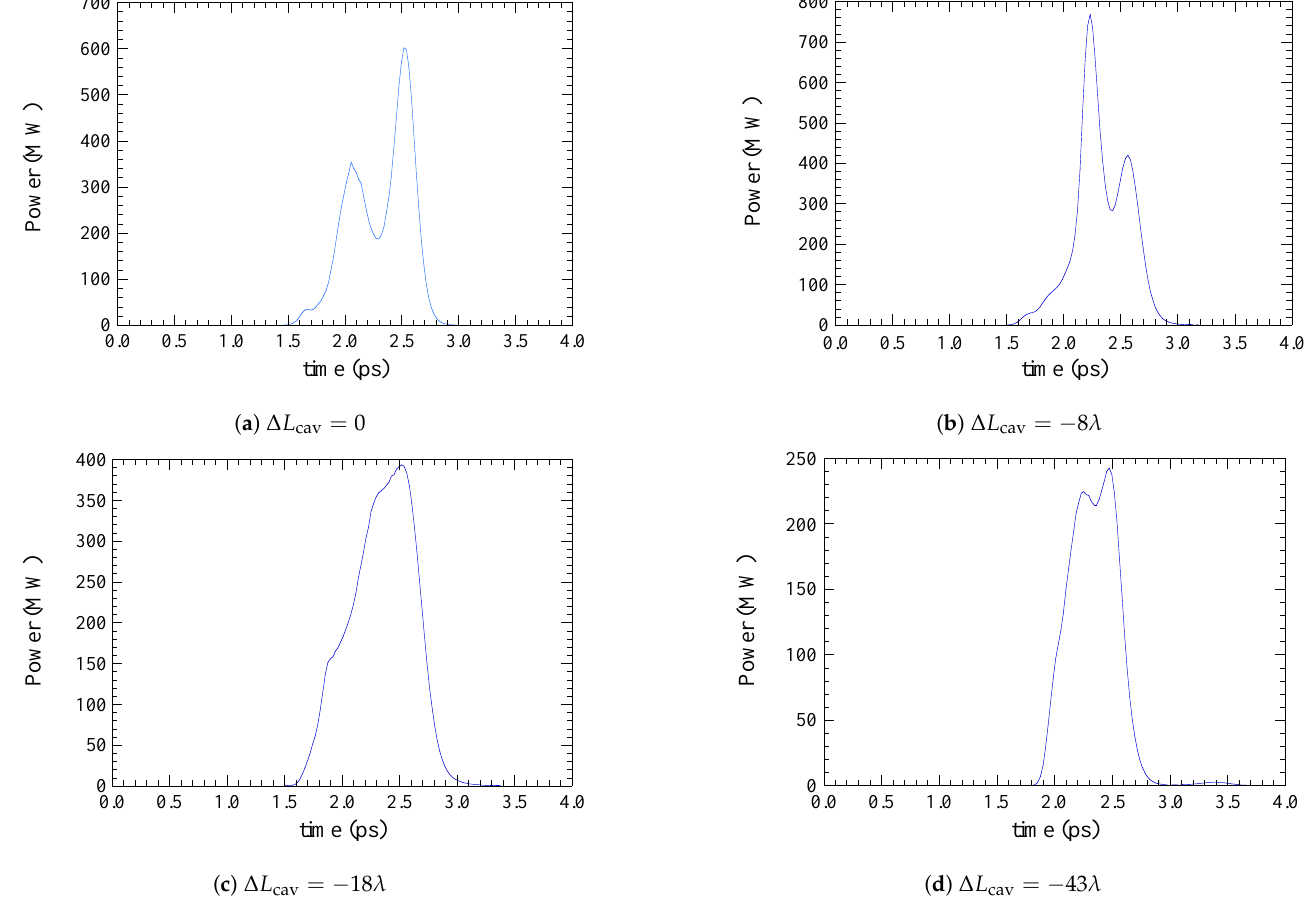
Figure 20. Temporal pulse shape at the exit of the undulator after 60 passes, and for various cavity detunings. The undulator field strength is B u = 6.658 kG ( K rms = 1.055). The other parameters are given in Table